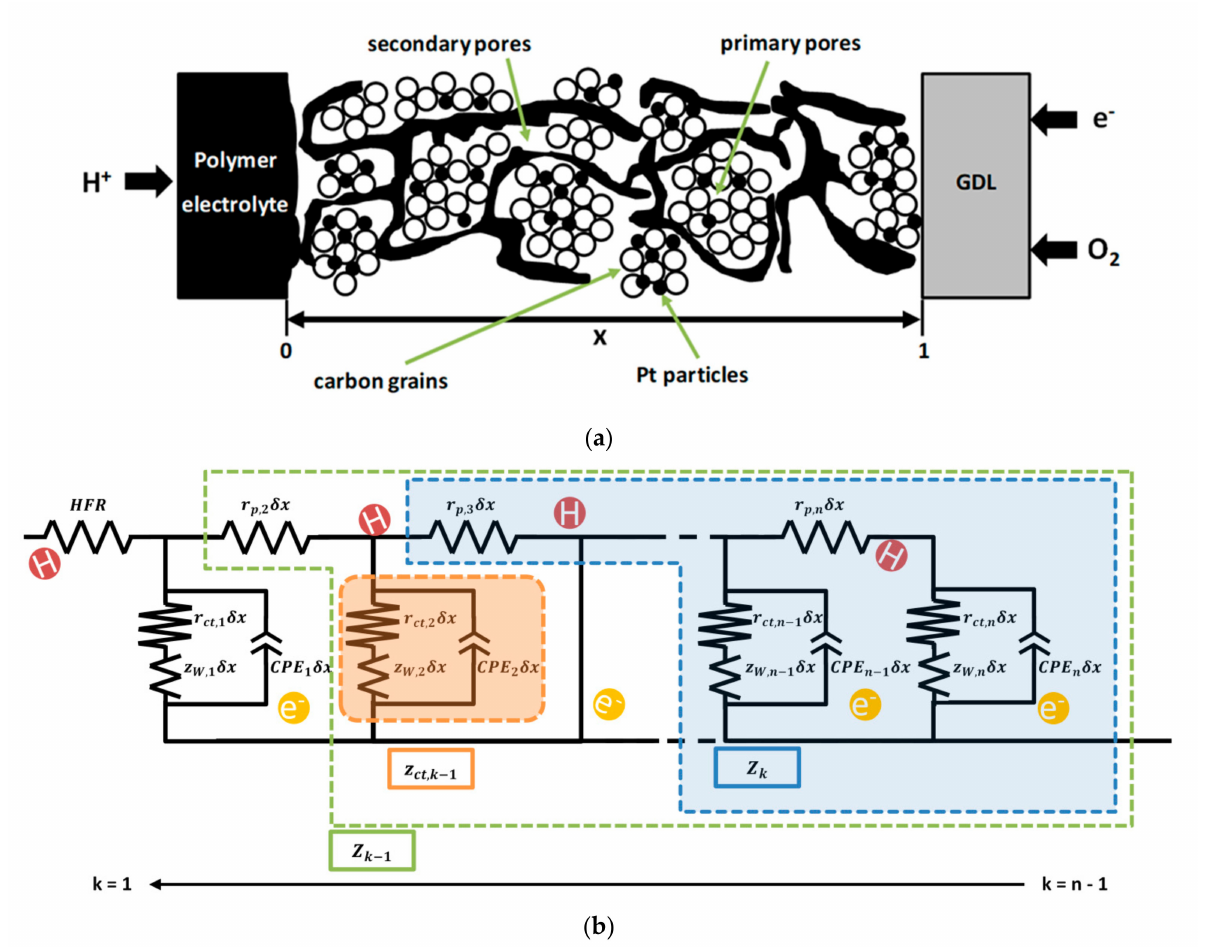
Figure 2. ( a ) A schematic of the catalyst layer (CCL). x represents the non-dimensional thickness of the CCL from the CCL/GDL interface ( x = 1) to the polymer electrolyte membrane (PEM)/CCL interface ( x = 0). ( b ) Electrical equivalent circuit of a PEM fuel cell represented by a transmission-line model (TLM)